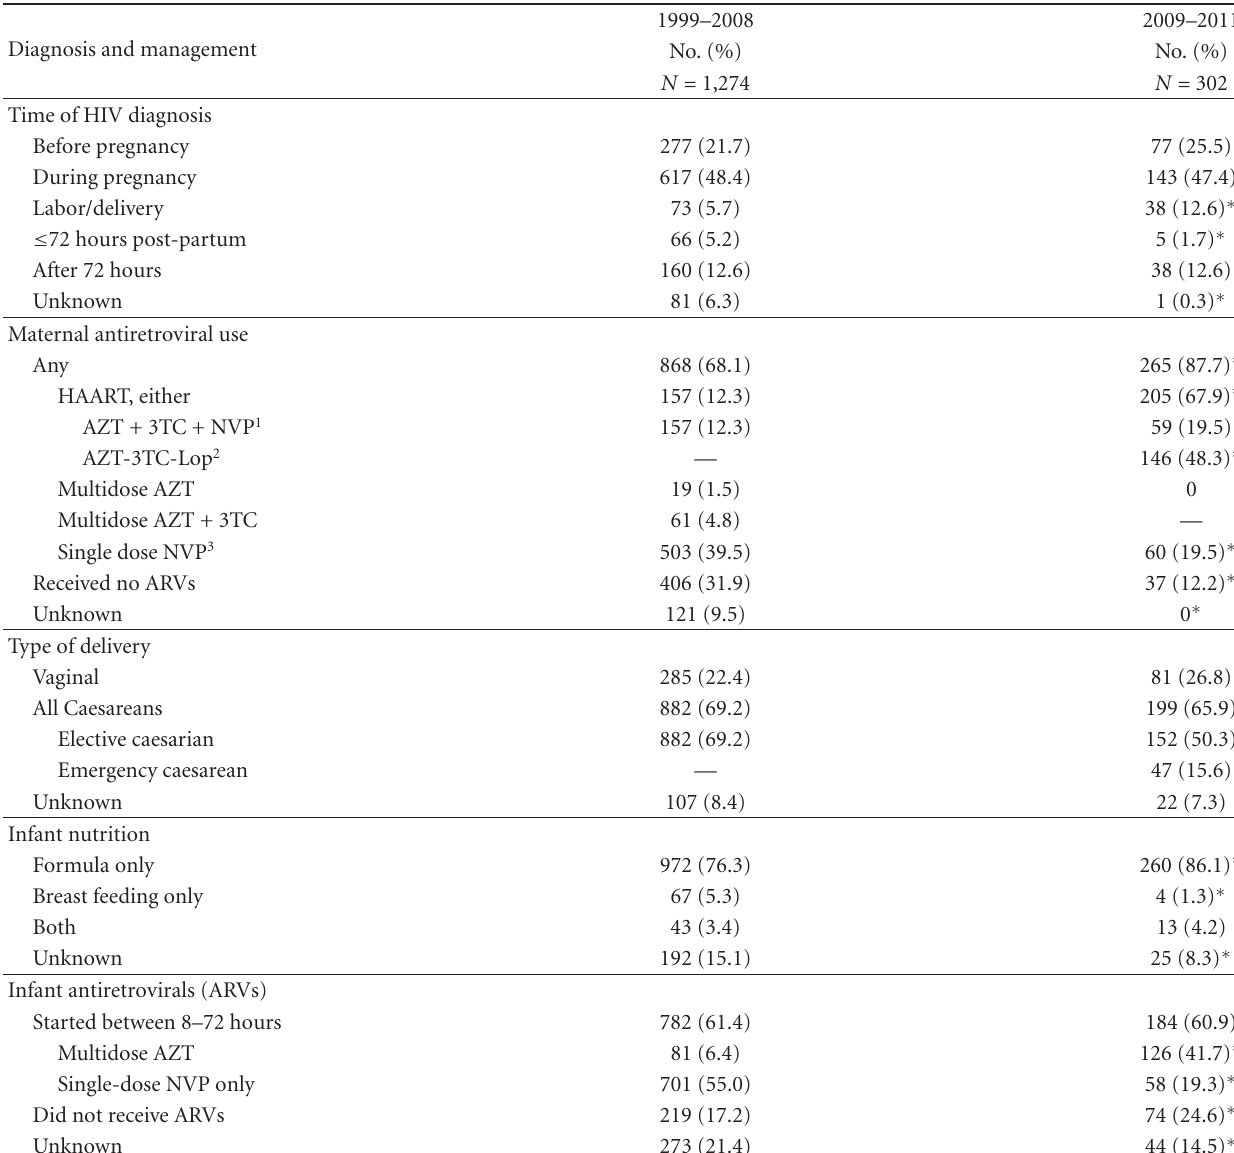
Table 1: Characteristics of maternal HIV diagnosis, maternal and infant antiretroviral use, mode of delivery and infant feeding,